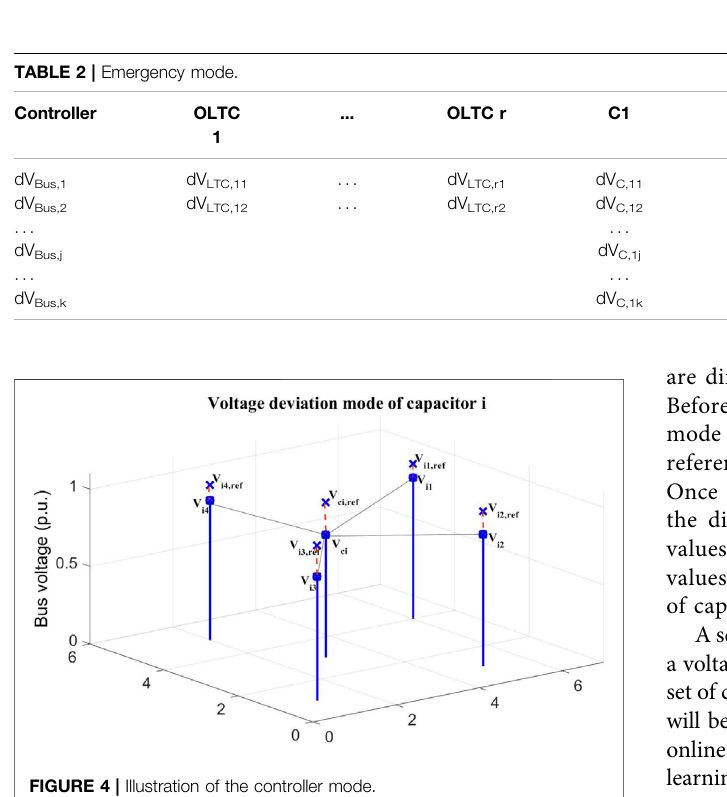
FIGURE 4 | Illustration of the controller